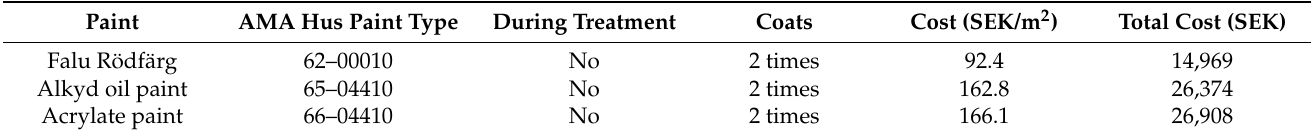
Table 3. Costs of a wooden facade maintenance conducted by private